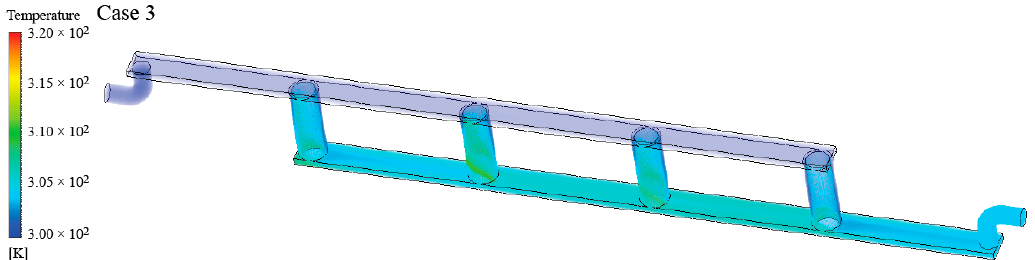
Figure 9. 3D visualization of the temperature field for the modification Case 3 where a uniform temperature is visible along the entire length of the distribution channel. temperature is visible along the entire length of the distribution channel.